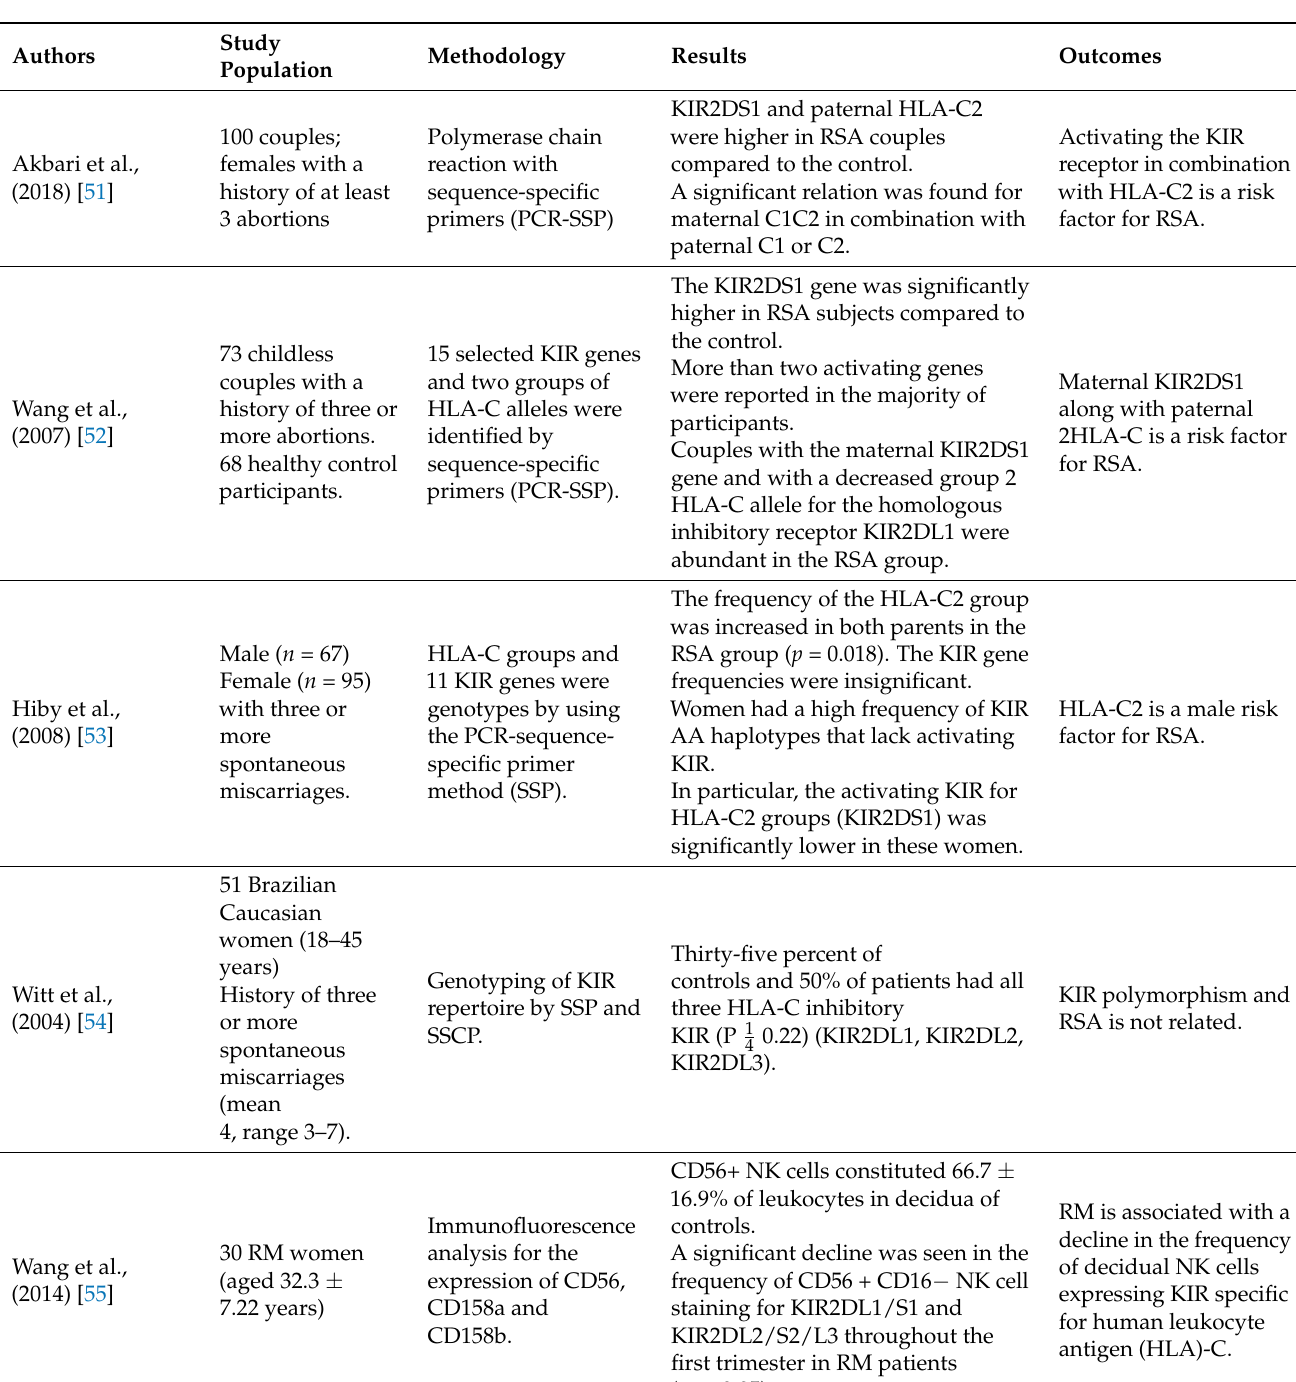
Table 1. The role of KIR in the predisposition of